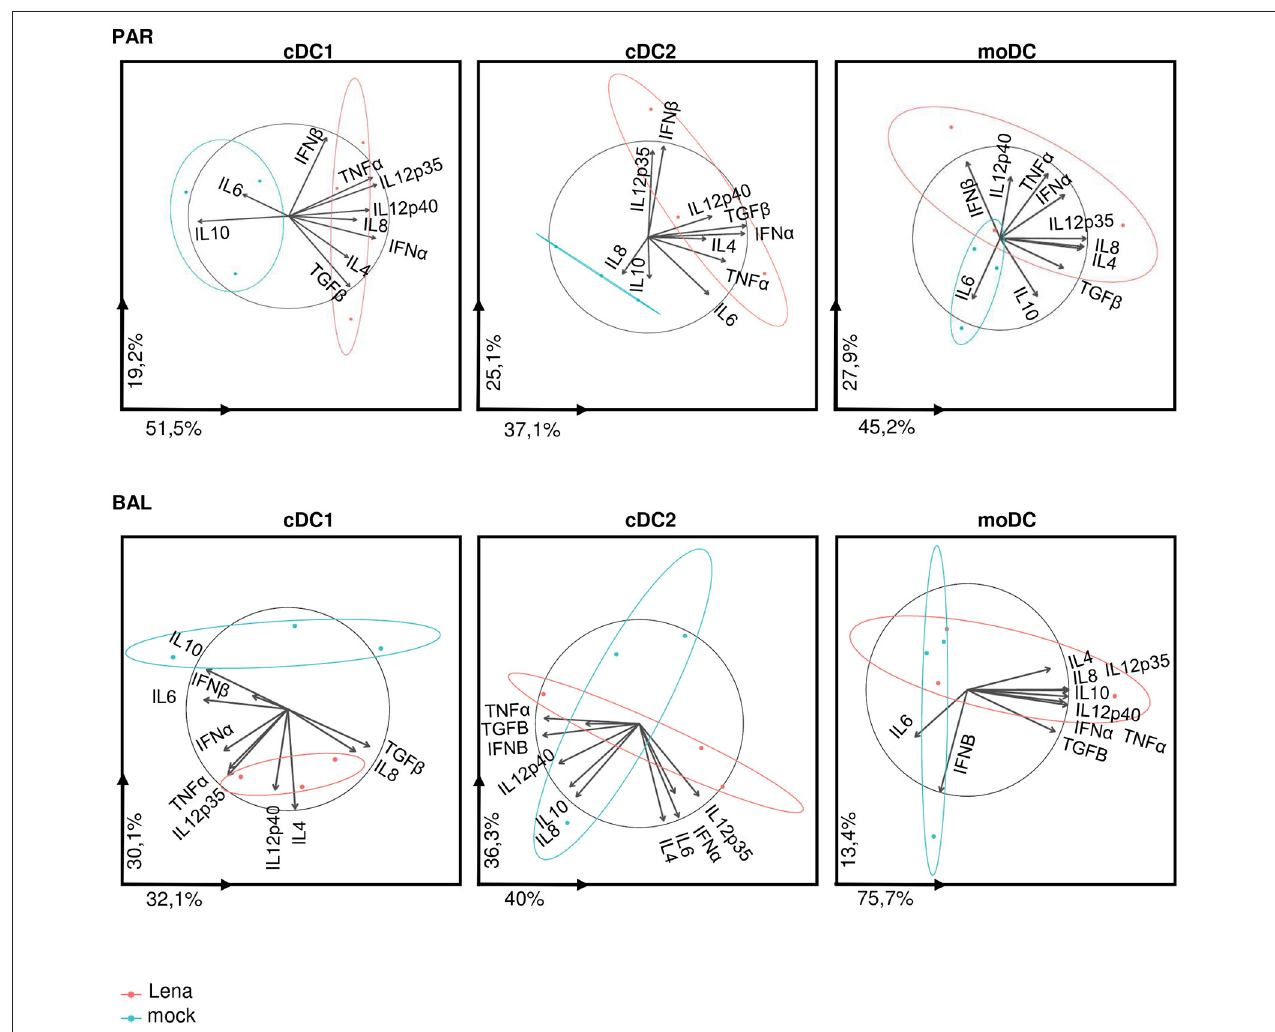
FIGURE 7 | cDC1 are activated upon in vivo Lena infection. Principal Component Analysis (PCA) of DCs cytokines profile from PAR and BAL. The parameter values are cytokine mRNA expressions of sorted DCs from in vivo infected animals ( Figure 6 ). Each pig is represented as a dot of specific color according to its group Mock (blue) or Lena (red). The percentages indicated on the axis represents the variance between individuals explain by this axis. The PCA was done with 10 factors (each of one represent a cytokine). PCA graphics has been produced using FactoMineR R package (version 1.39) ( 29). The ellipses depict the spread of the PCA data for mock or Lena infected conditions (blue and red respectively). Non-overlapping ellipses attest a significant difference in the global cytokine profile between mock and infected